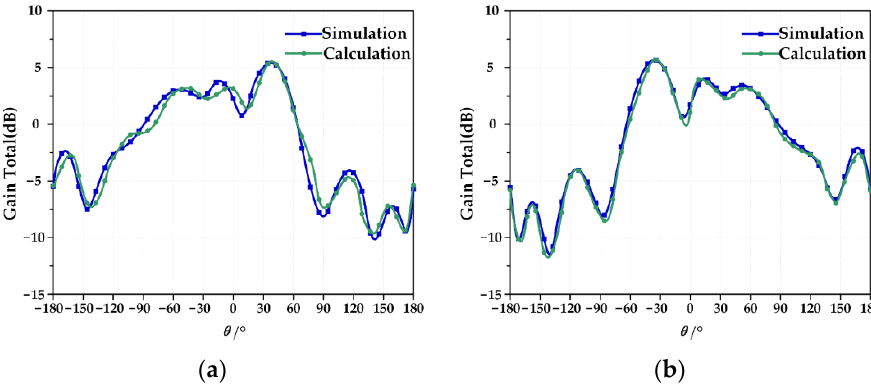
Figure 9. ( a ) Comparison of equation calculation and simulation results of Mode 3 antenna; ( b ) Comparison of equation calculation and simulation results of Mode 4 antenna.